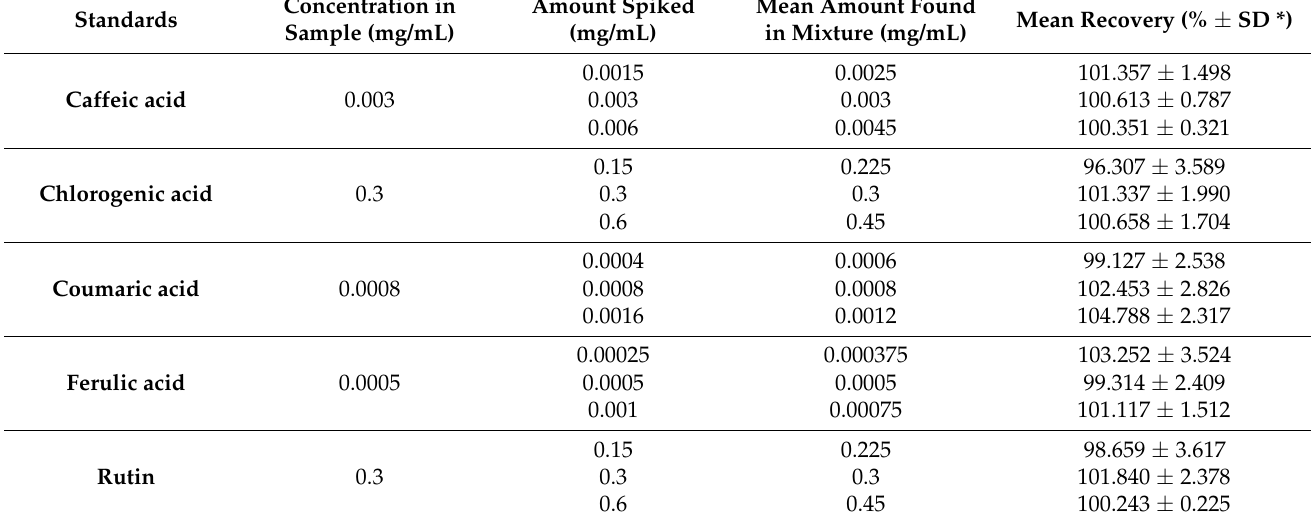
Table 4. Recovery assay statistical data ( n =